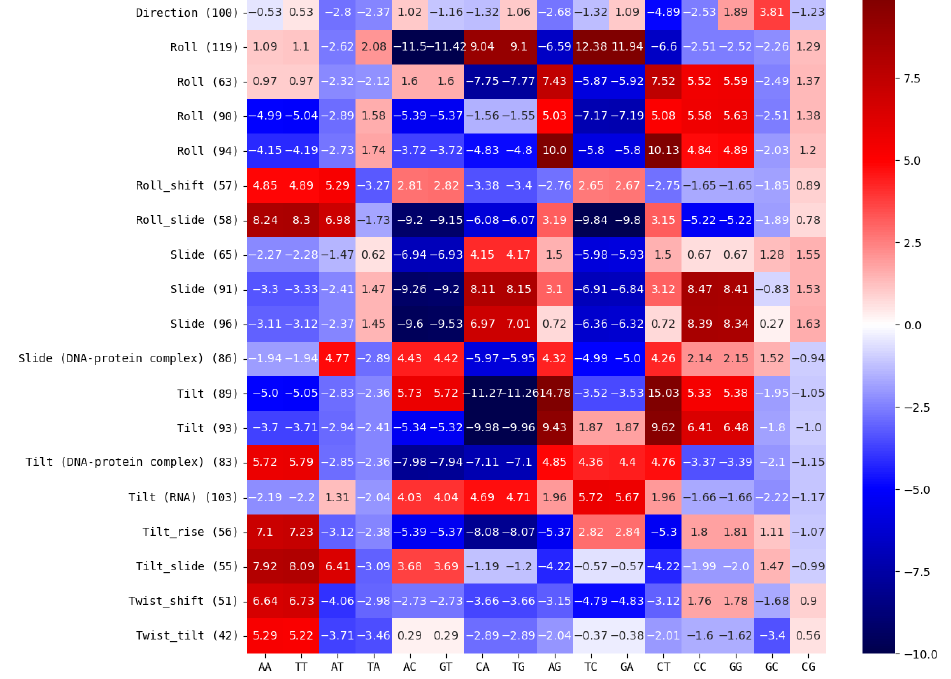
Figure 5. Significance levels of dinucleotide content contributions to DNA properties: heatmap of significance level contributions from dinucleotides to physical/conformational/structural DNA properties (see Section 2.5 for details on calculation). The DNA property model IDs in brackets and DNA property names were taken from the dinucleotide properties database [6]. Different IDs for the same property name represent independent models for the same property. DNA properties without any significantly contributing dinucleotides leading to changes of at least 10% are not listed (see Table S4). Contributions with significance levels above >1 σ were considered significant (see Table S5).